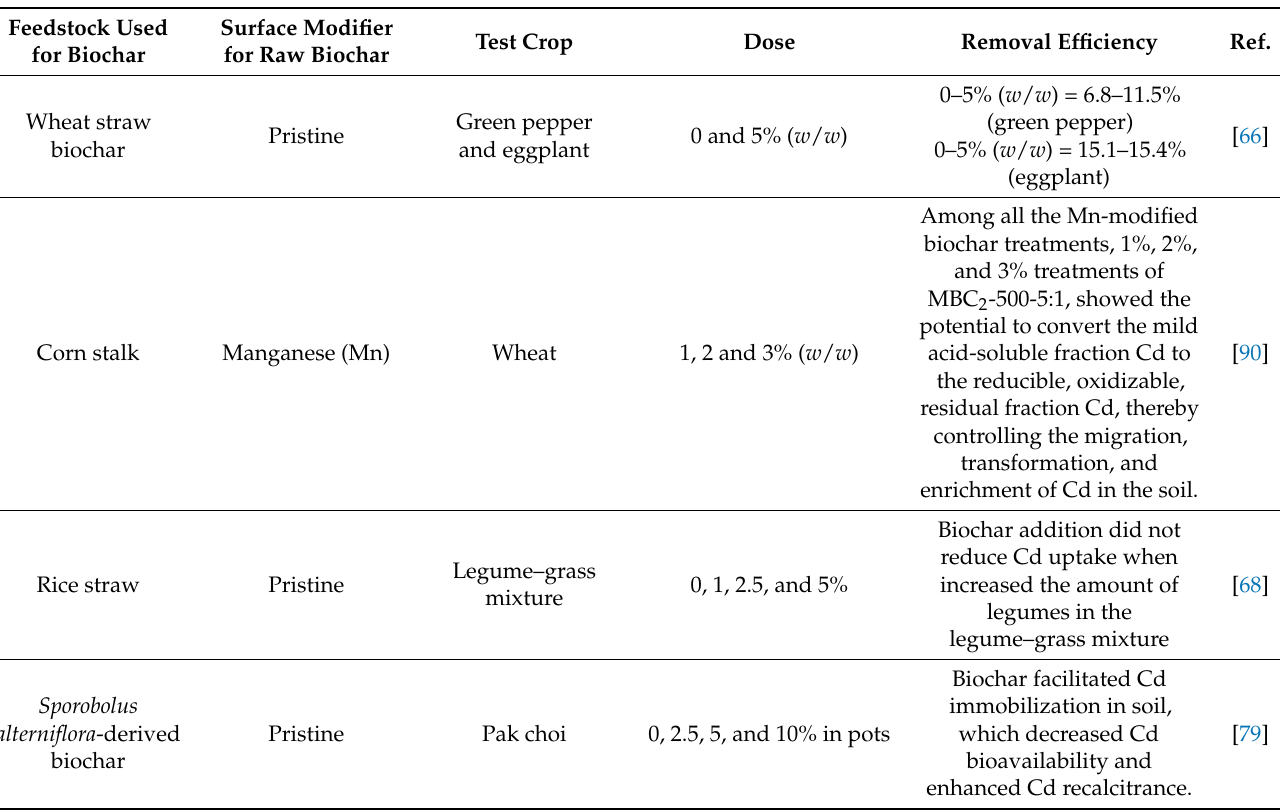
Figure 3. Underlying mechanisms in soil cadmium (Cd) fixation by biochar [68]. Table 2. Efficiency of the remediation of cadmium (Cd(II))-contaminated soils by pristine biochar and modified biochar in different studies. NR = not